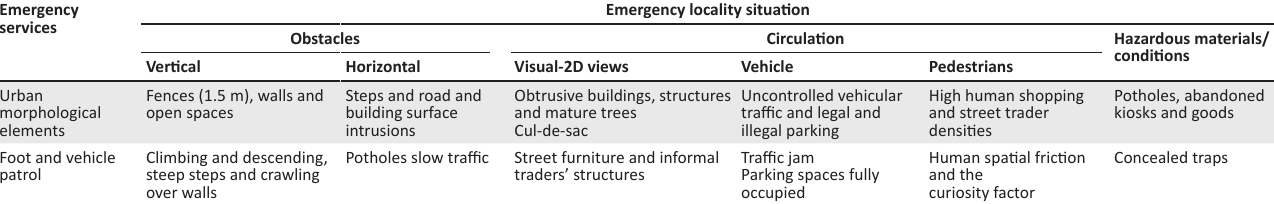
TABLE 2: Hazards generated from ‘worst case scenarios’ for the police